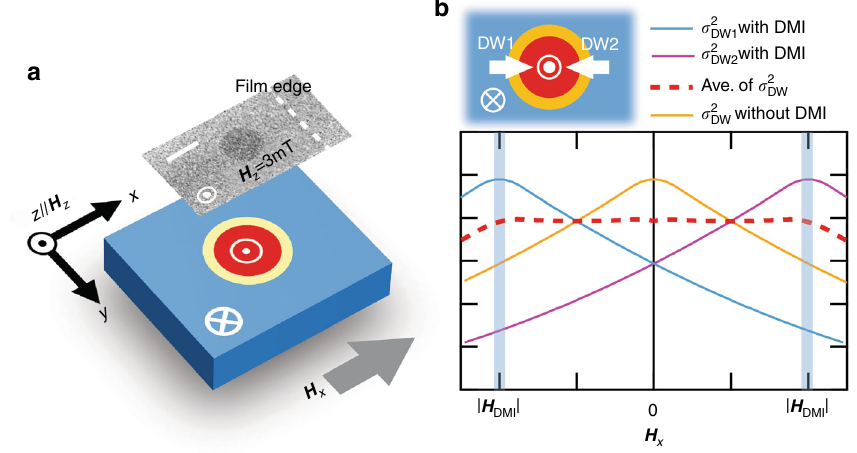
Fig. 1 Droplet nucleation with DMI. a Schematic image of a magnetic droplet in a ferromagnetic medium under H z and H x . Inset shows a magneto-optical Kerr effect (MOKE) image to prove the droplet nucleation inside the Pt/Co/MgO microstrip. The white bar is a scale bar of 5 μ m. b Schematic diagrams of σ 2 in terms of H x . Inset shows the magnetization alignments of the DW1 and DW2 in the DW of the droplet. The thresholds in the curve of averaged σ 2 DW are highlighted with blue